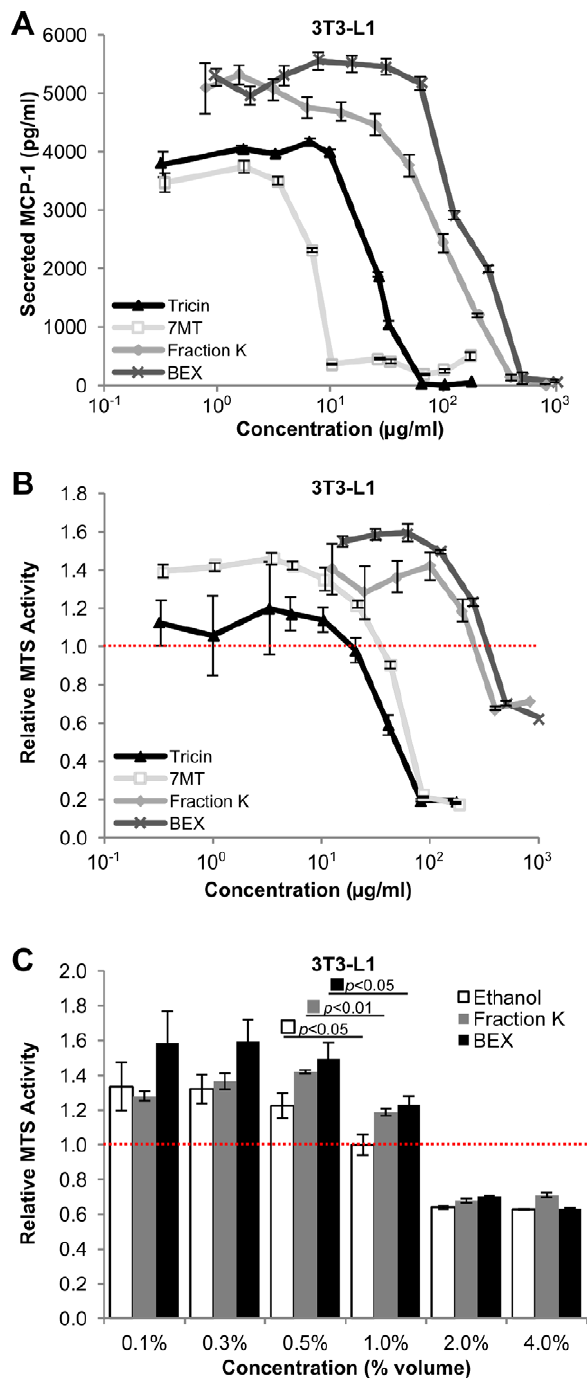
Figure 6. Dose-dependent effects of tricin, 7-O-methyl-tricin (7 MT), Fraction K, and BEX on lipotoxic MCP-1 production and cell viability. (A) MCP-1 concentrations in cell culture media from 3T3- L1 cells cultured in 96 well plates and treated for 20 hours with PA (0.4 mM) and one of the following: tricin (black triangles), 7 MT (light grey hollow squares), Fraction K (grey diamonds), or BEX (dark grey crosses). Concentrations were determined by cytometric bead array immunodetection against a reconstituted MCP-1 standard. Mean 6 standard error of 3 samples per dose, n $ 300 beads per sample. (B) Viability of 3T3-L1 cells treated with tricin (black triangles), 7 MT (light grey hollow squares), Fraction K (grey diamonds), or BEX (dark grey crosses) added to maintenance medium. All values are normalized